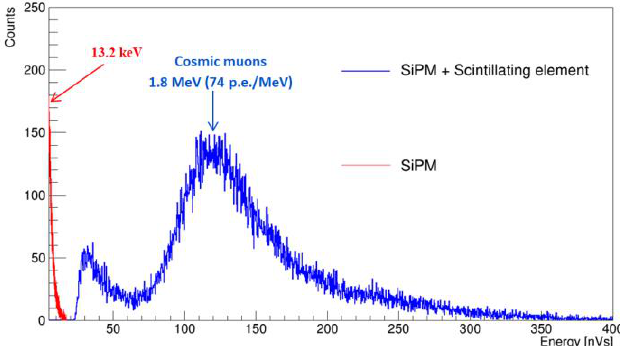
Fig. 9. An example of the spectrum. Red line corresponds to the SiPM self- noise. The blue line represents the pulse-height spectrum of the physical background – the gamma and cosmic muon